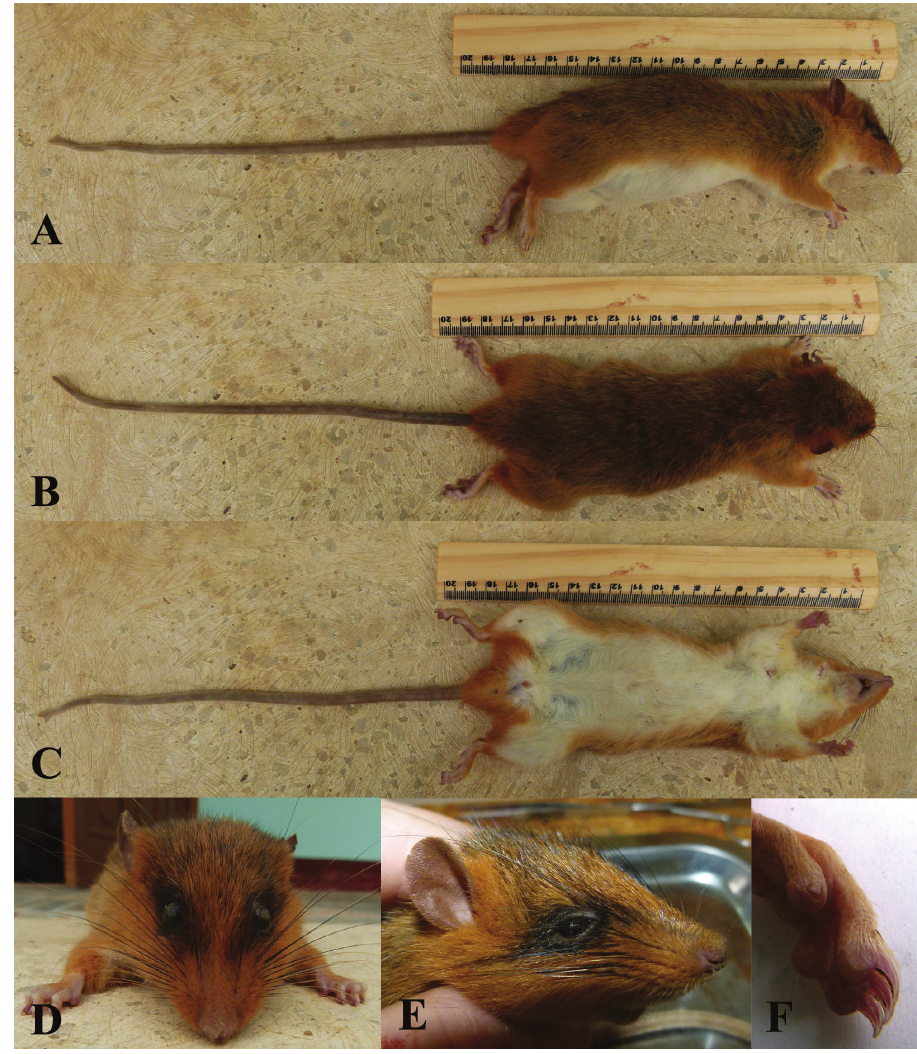
Figure 7. The paratype of Chiromyscus thomasi sp. n., Son La Province, northern Vietnam, specimen ZIN 101651, genetic voucher MC80. A Lateral view B Dorsal view C Ventral view D Head, face view E Head, lateral view F Hallux of the hind foot with the